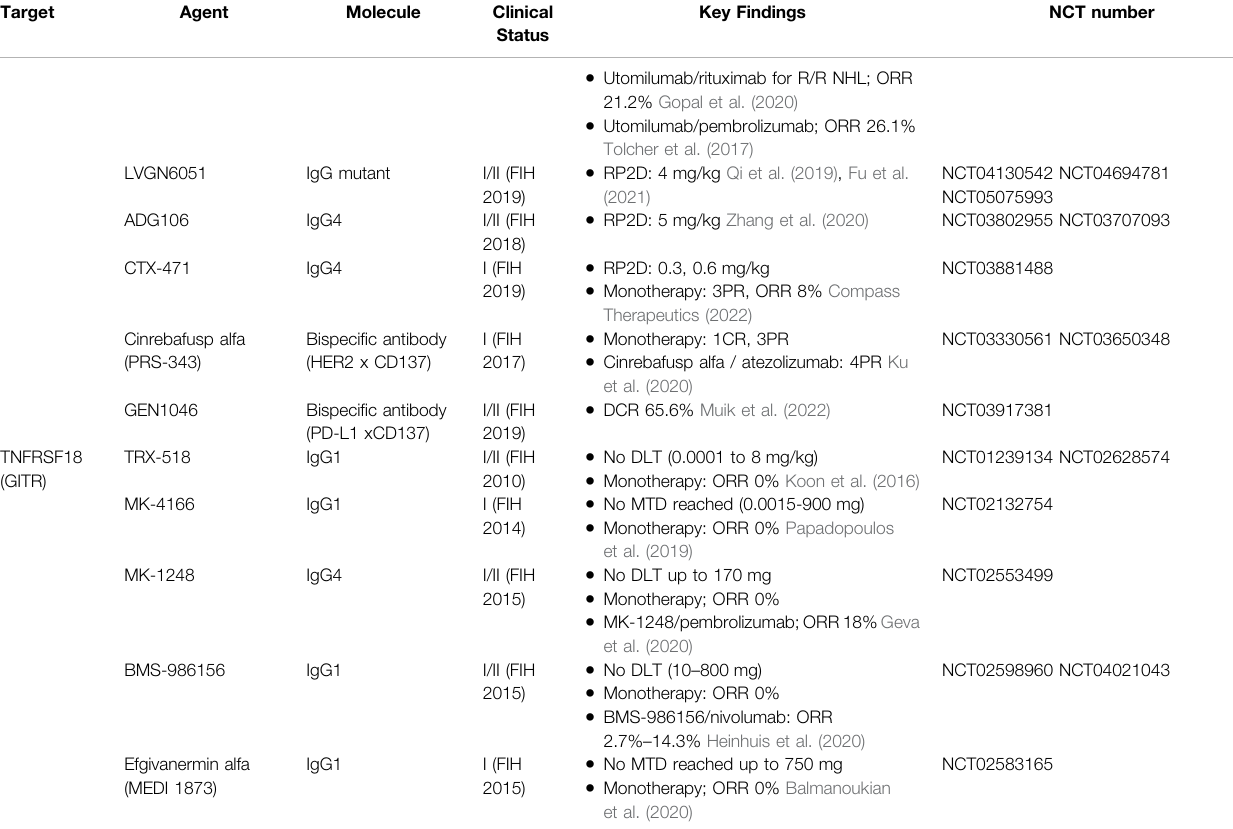
Target Agent Key Findings NCT